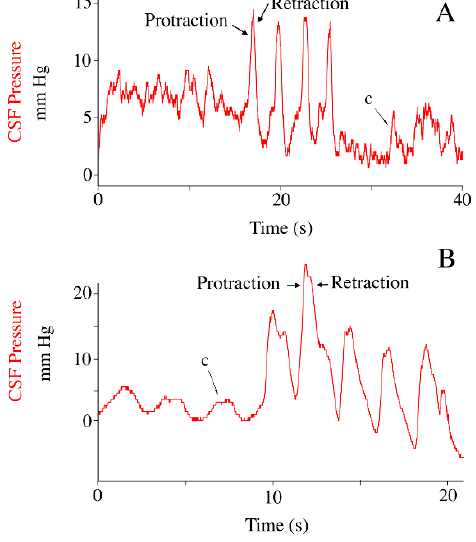
Figure 5. The impact of hind limb displacement on CSF pressure. Traces from two individuals of Alligator mississippiensis ( A , B ) showing the similar patterns of CSF pulsations (red) recorded during movement of the pes. Protraction of the pes caused an increase in CSF pressure, which decreased during retraction of the pes. c—individual cardiac-related pulsation.